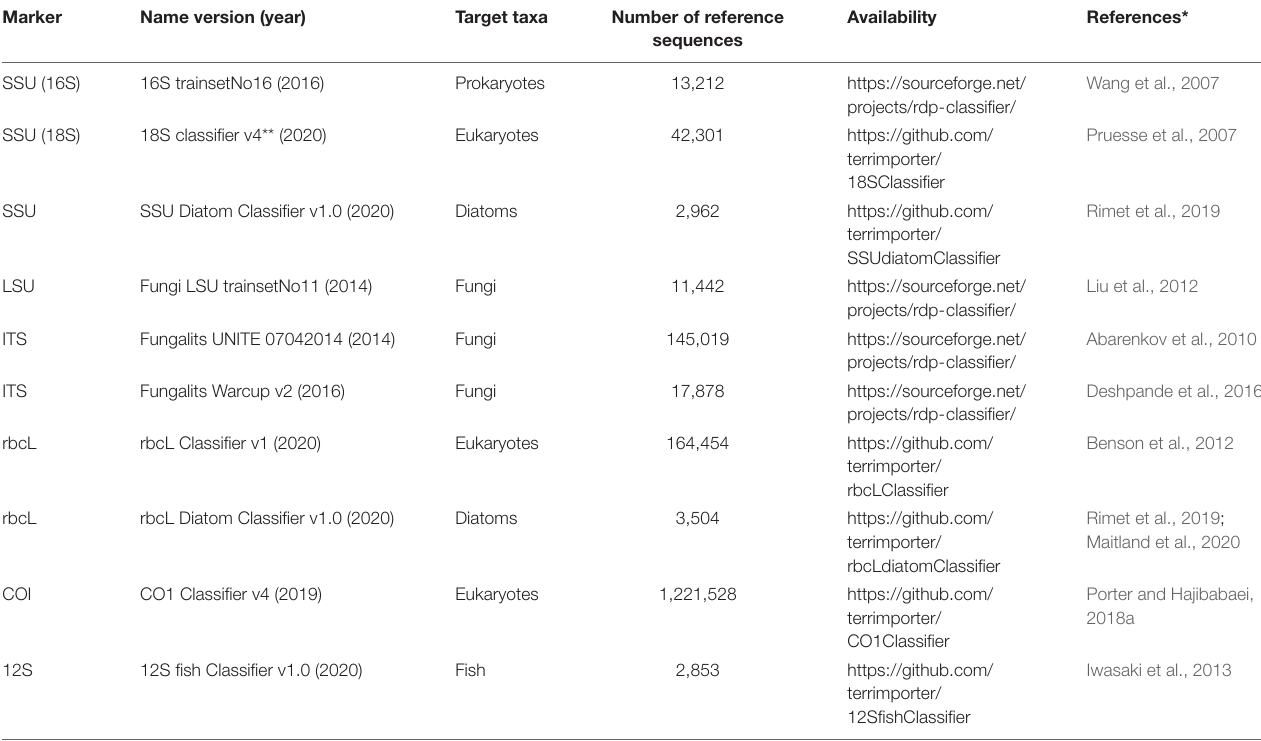
TABLE 3 | Curated reference sequence databases specifically formatted to work with the RDP naive Bayesian classifier.